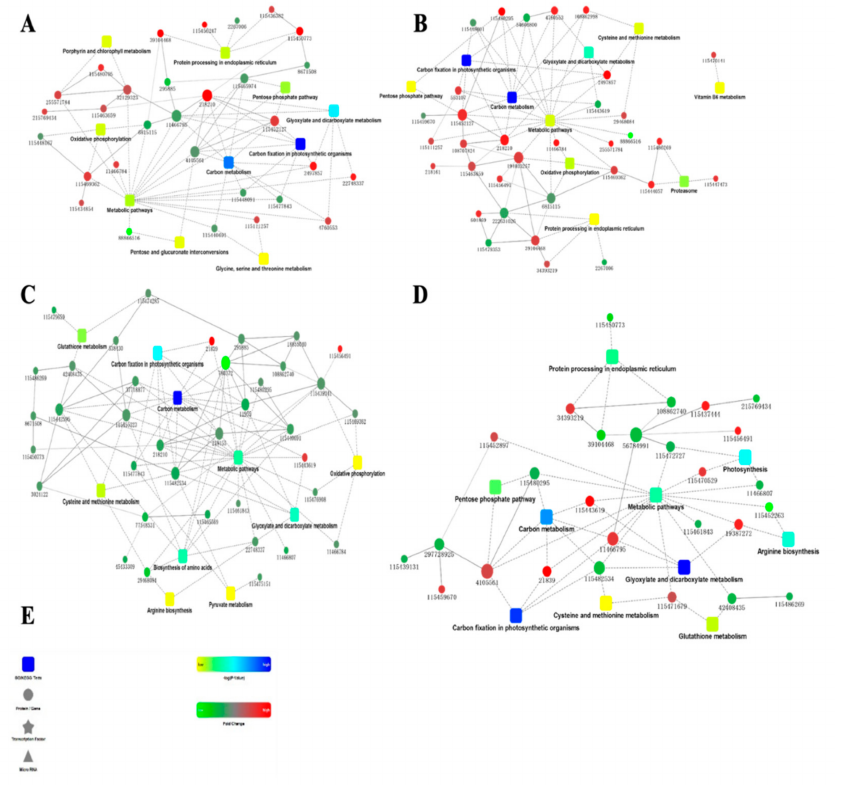
Figure 6. The protein-protein interaction of differentially expressed proteins. The figures show the top ten entries according to the same significant degree as the KEGG analysis (Figure 5). ( A ) Represents the M-M group. ( B ) The M-SA group. ( C ) The R-M group. ( D ) The R-SA group. ( E ) Marginal data of protein-protein interaction results. The dots represent proteins; red means upregulated; green means expression. The rounded rectangles represent the enriched pathways, color from yellow to blue gradient indicates significance from low to high, respectively. A solid line indicates the protein interaction that had been reported, and dotted line that had no experimental results. The ID or names of dots and rounded rectangles are displayed